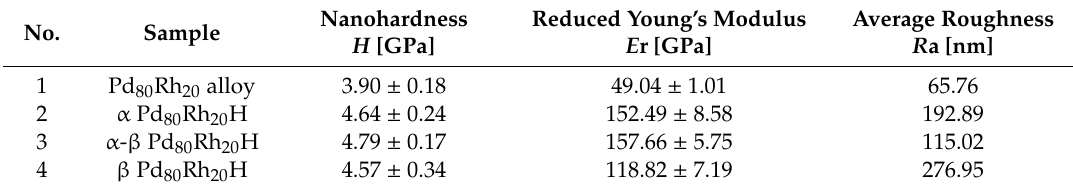
Table 1. Nanohardness, reduced Young’s modulus, and average roughness values for the Pd 80 Rh 20 alloy and α , α - β , β Pd 80 Rh 20 H.